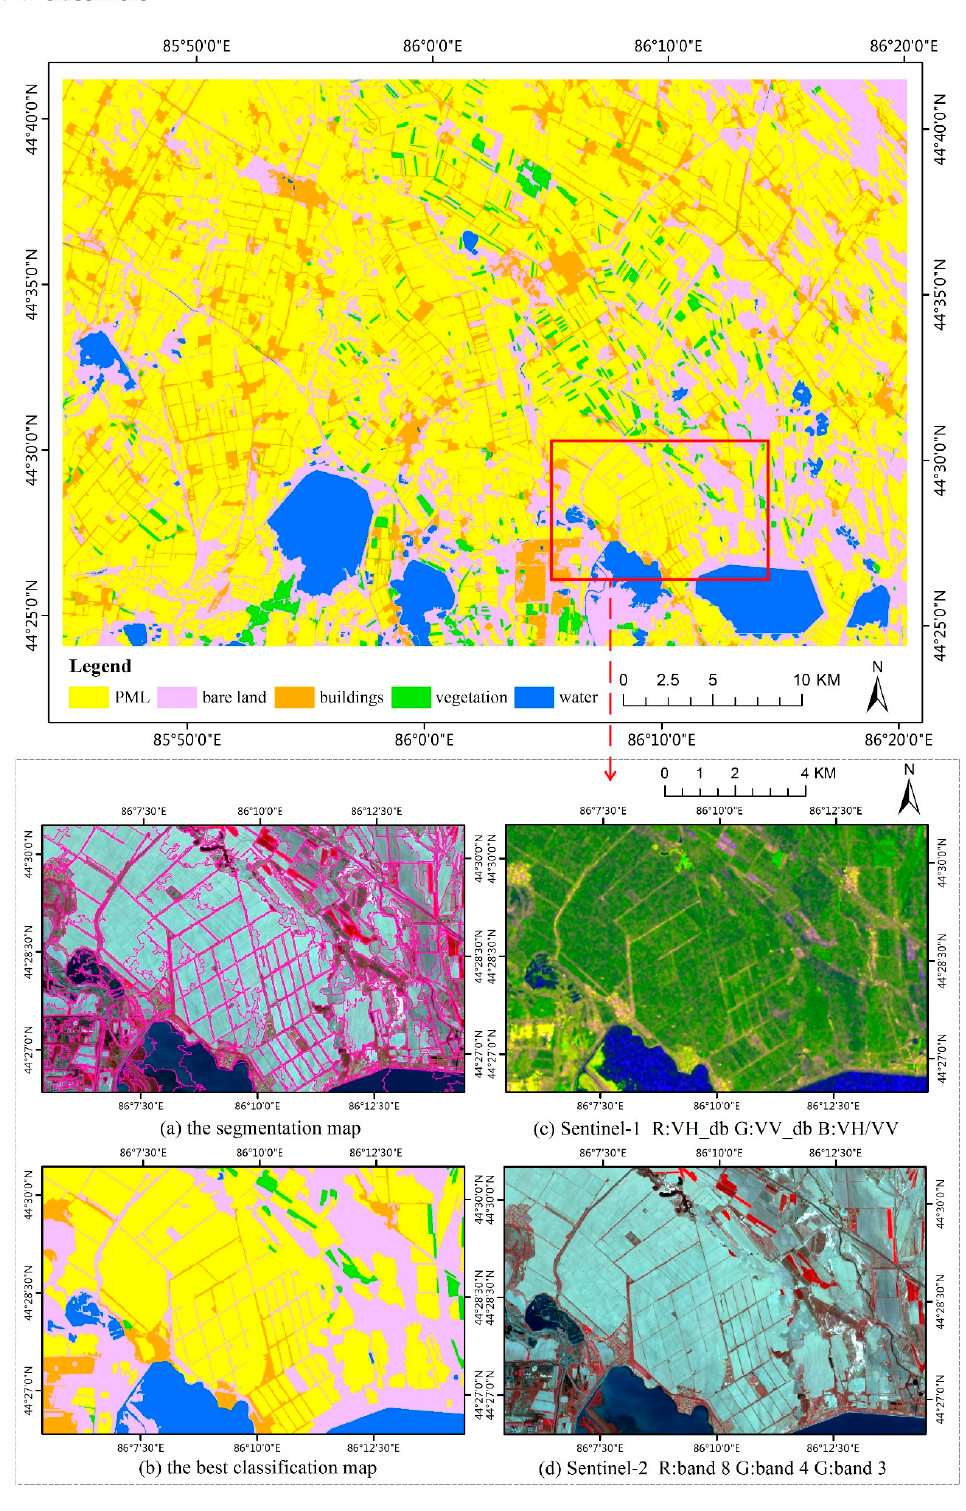
Figure 6. The best Plastic-Mulched Landcover (PML) classification: using spectral, index, and textural features on integrated Sentinel-1 and Sentinel-2 data with the SVM classifier. In the zoomed area: ( a ) the best segmentation result, ( b ) the best PML classification, ( c ) Sentinel-1 false color image: R:VH_db, G: VV_db, B: VH/VV, ( d ) Sentinel-2 false color image: R: band 8, G: band 4, B: band 3.